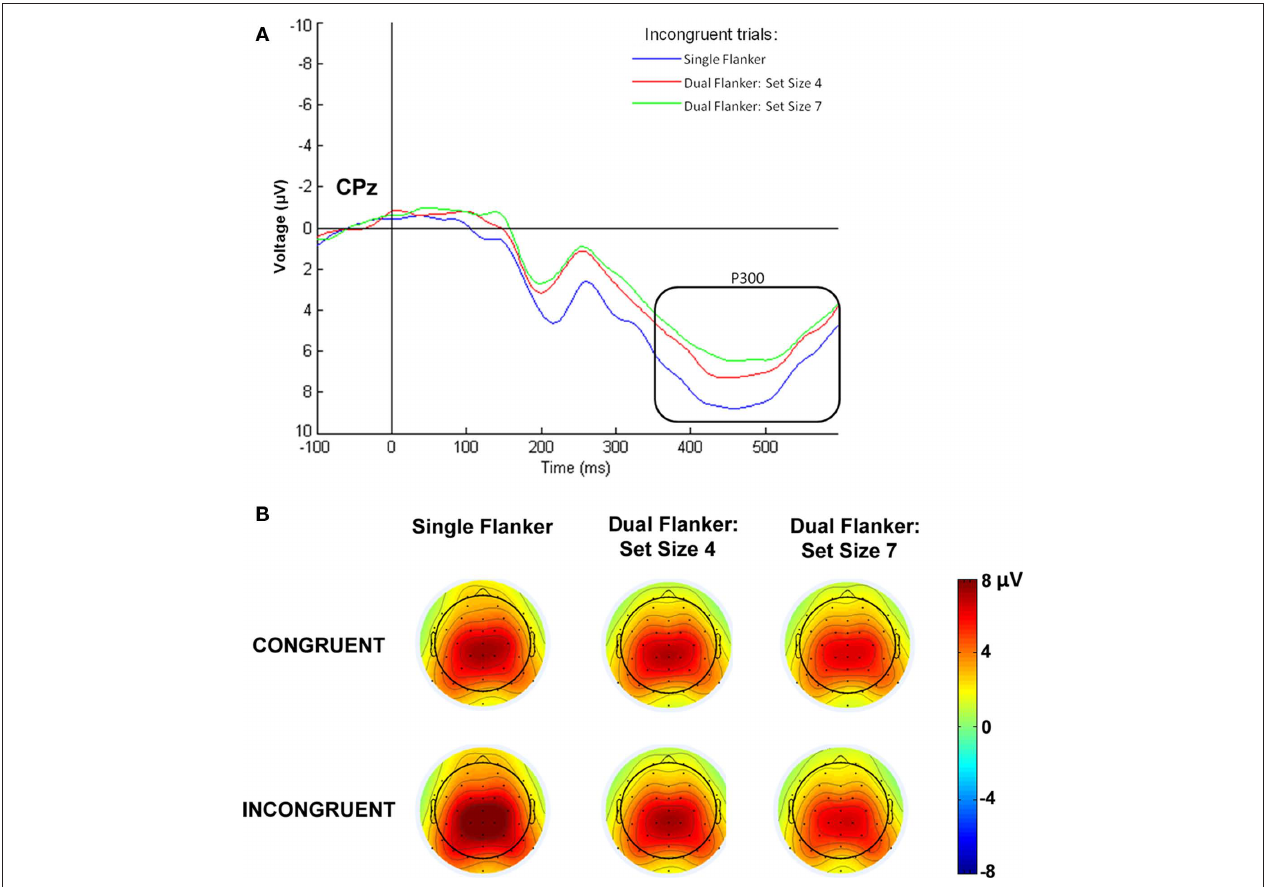
FiguRE 5 | P300 to incongruent flankers in response to load. (A) The P300 response significantly decreased to incongruent flanker stimuli in the dual task condition compared to the single task condition at electrode CPz. (B) Topographic maps display the scalp voltage distribution at 450 ms, showing the interaction of congruence